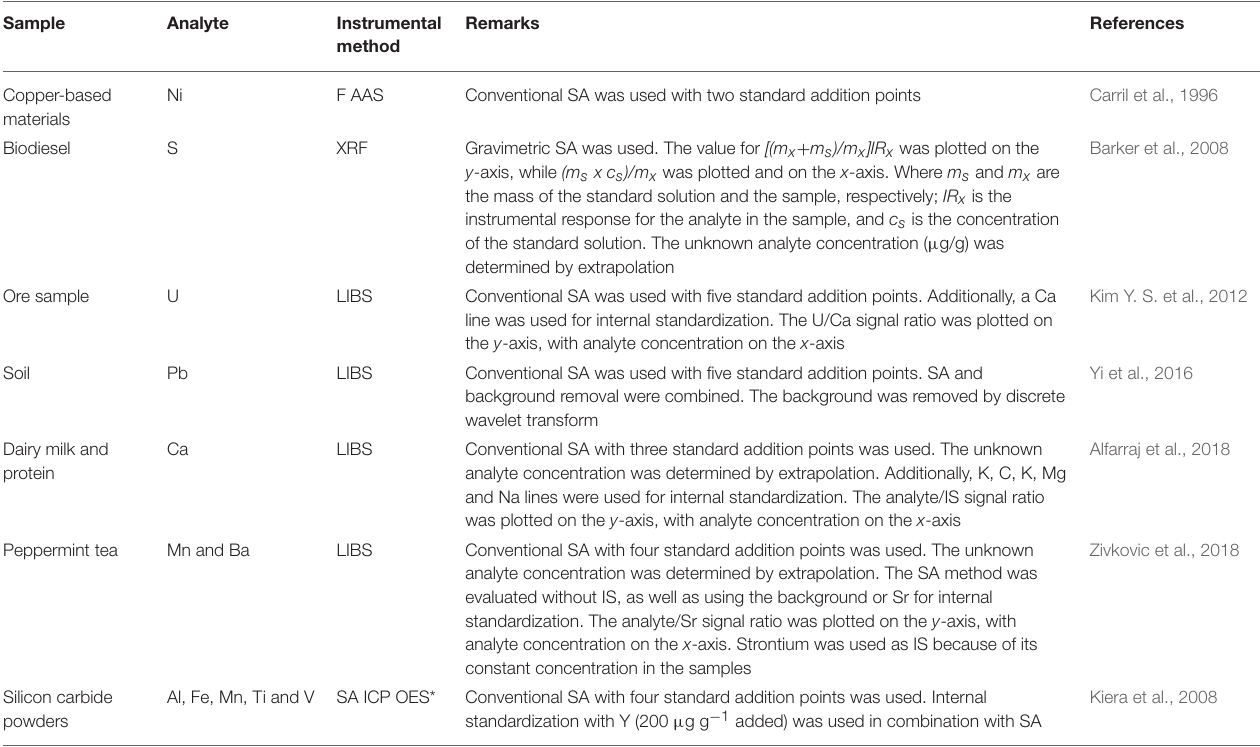
TABLE 3 | Selected applications of the SA method associated with instrumental spectroanalytical